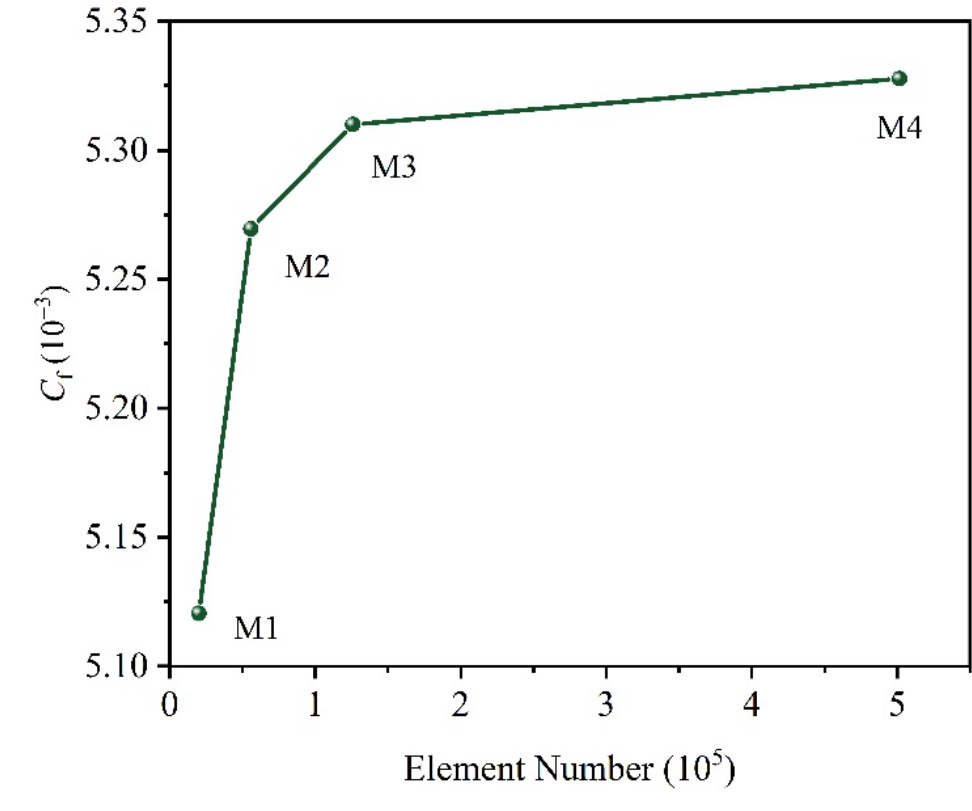
Figure 4. The results of mesh convergence analysis in the simulations.